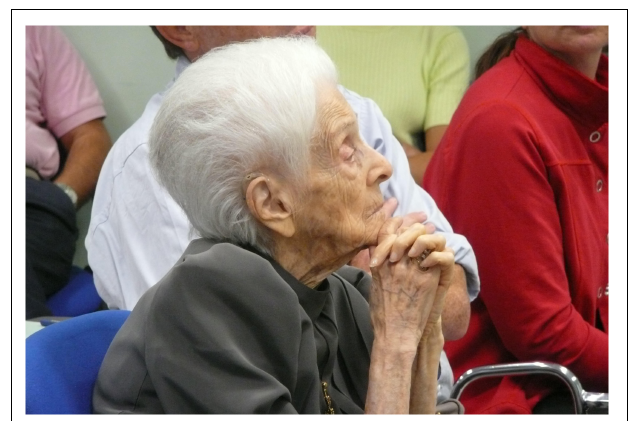
FIGURE 1 | Rita Levi-Montalcini during a seminar at EBRI [Photographer Federico La Regina (EBRI) from EBRI Media